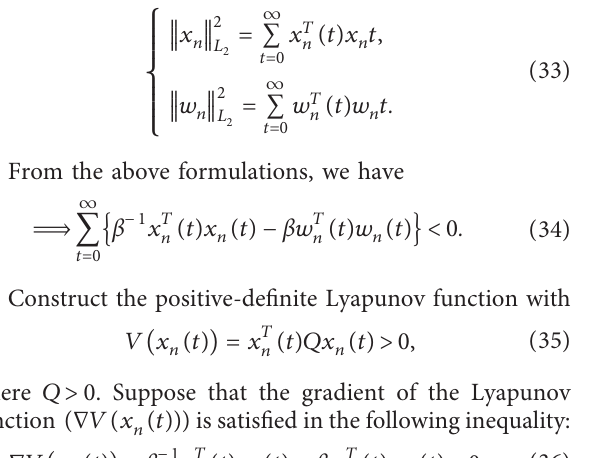
Figure 5: U -control implementation.